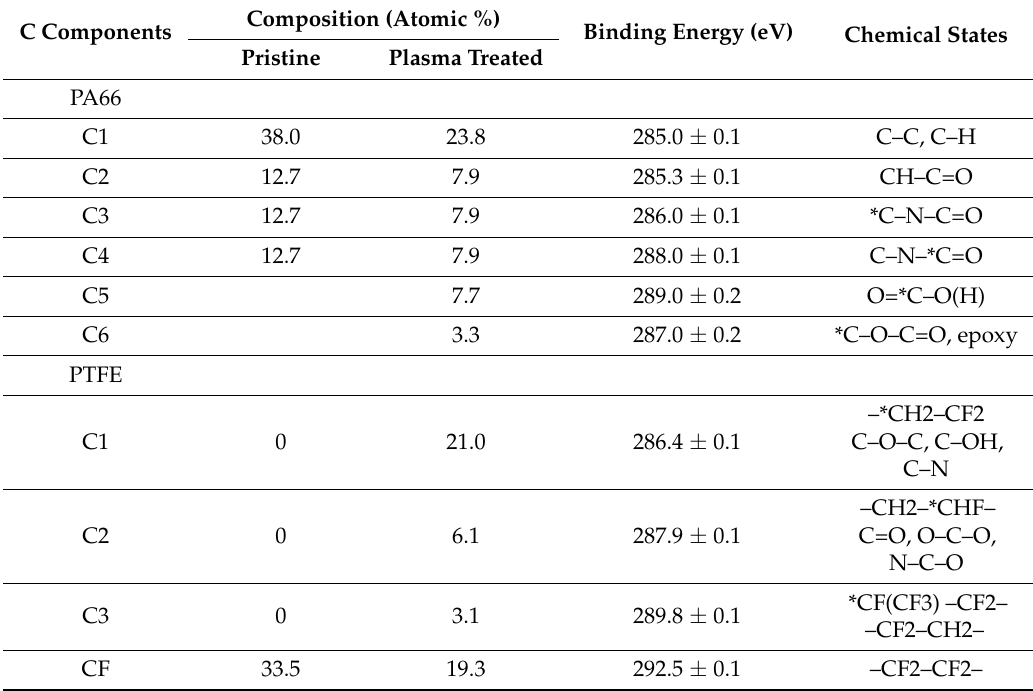
Table 4. Surface composition and chemical state assignments of the C1s components of the pristine and plasma treated PA66 and PTFE polymer